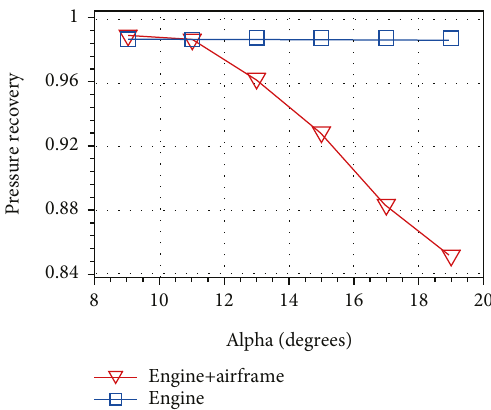
Figure 28: The inlet distortion of the engine alone at di ff erent attack angles (low speed).